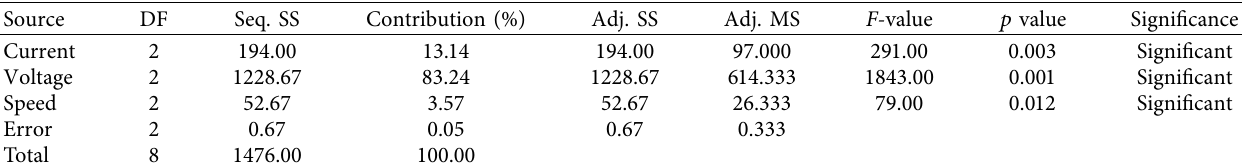
Figure 11: Main effects plot for means of tensile strength. Table 17: General linear model of tensile strength versus current, voltage, and